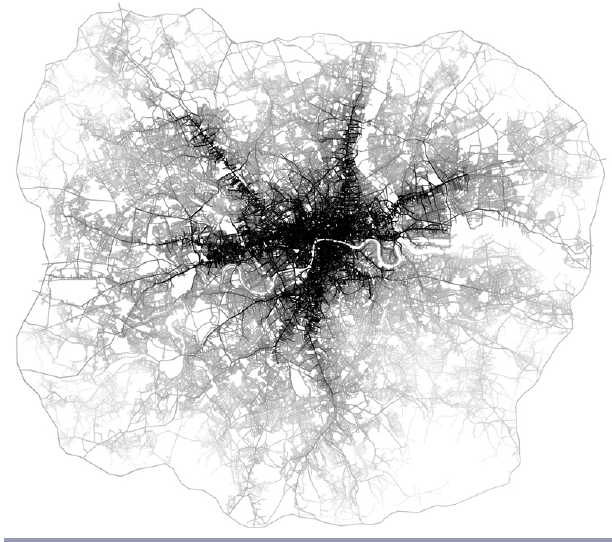
Fig. 8 . London within the M25 with its approximation of the deformed wheel, visualizing also the concept of the foreground and background network. Image © Bill Hillier and Laura Vaughan, with permission, originally published in the journal Progress in Planning ,